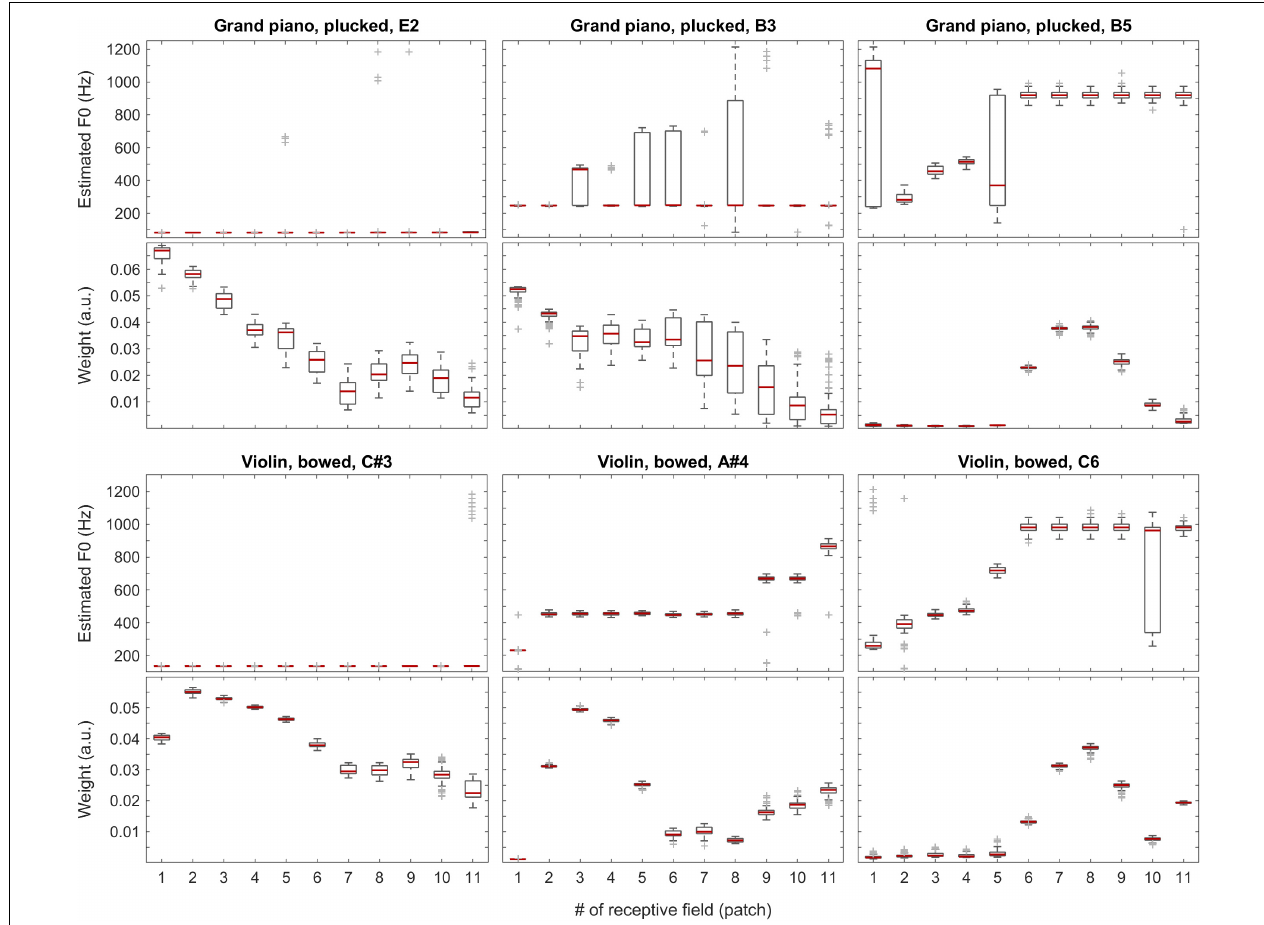
FIGURE 9 | F0 estimates (first and third rows) and weights (second and fourth rows) for all patches over all 100 iterations for the grand piano (top two rows) and violin (bottom two rows)